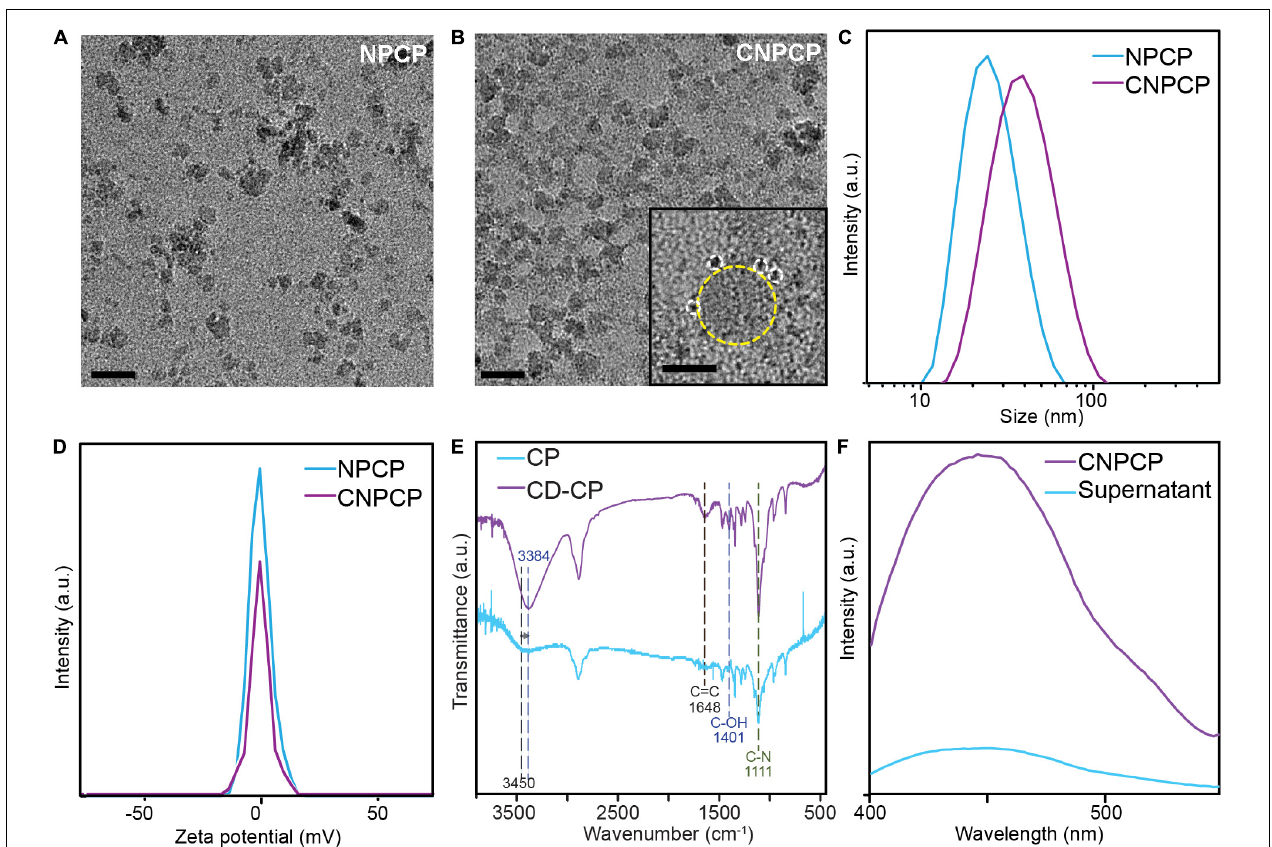
FIGURE 3 | Physicochemical characterization of NPCP and CNPCPs. TEM images of (A) NPCP (synthesized without CD-CP), and (B) CNPCPs. CDs (circled with white dashed circle) can be found surrounding the iron oxide core of CNPCP (yellow) (inset). Scale bar = 20 nm, 5 nm in inset) (C) Hydrodynamic sizes and (D) zeta potentials of NPCP and CNPCP. (E) FTIR spectra of CD-CP and CP. (F) Fluorescence emission of CNPCP solution before (CNPCP) and after (supernatant) magnetic separation of CNPCP from the